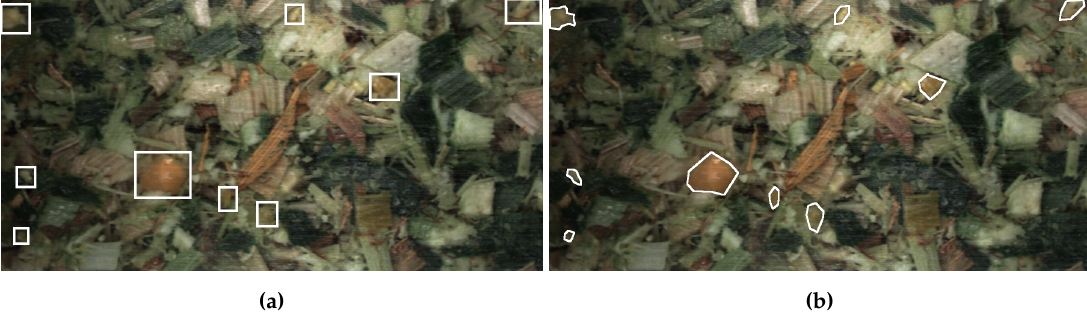
Figure 4. Examples of the difference in localisation granularity between bounding-boxes and segmentation. ( a ) Bounding-box localisation, ( b ) Segmentation localisation. The segmentation localisation fits much closer to the kernel instances and thereby can give a more precise measurement on kernel